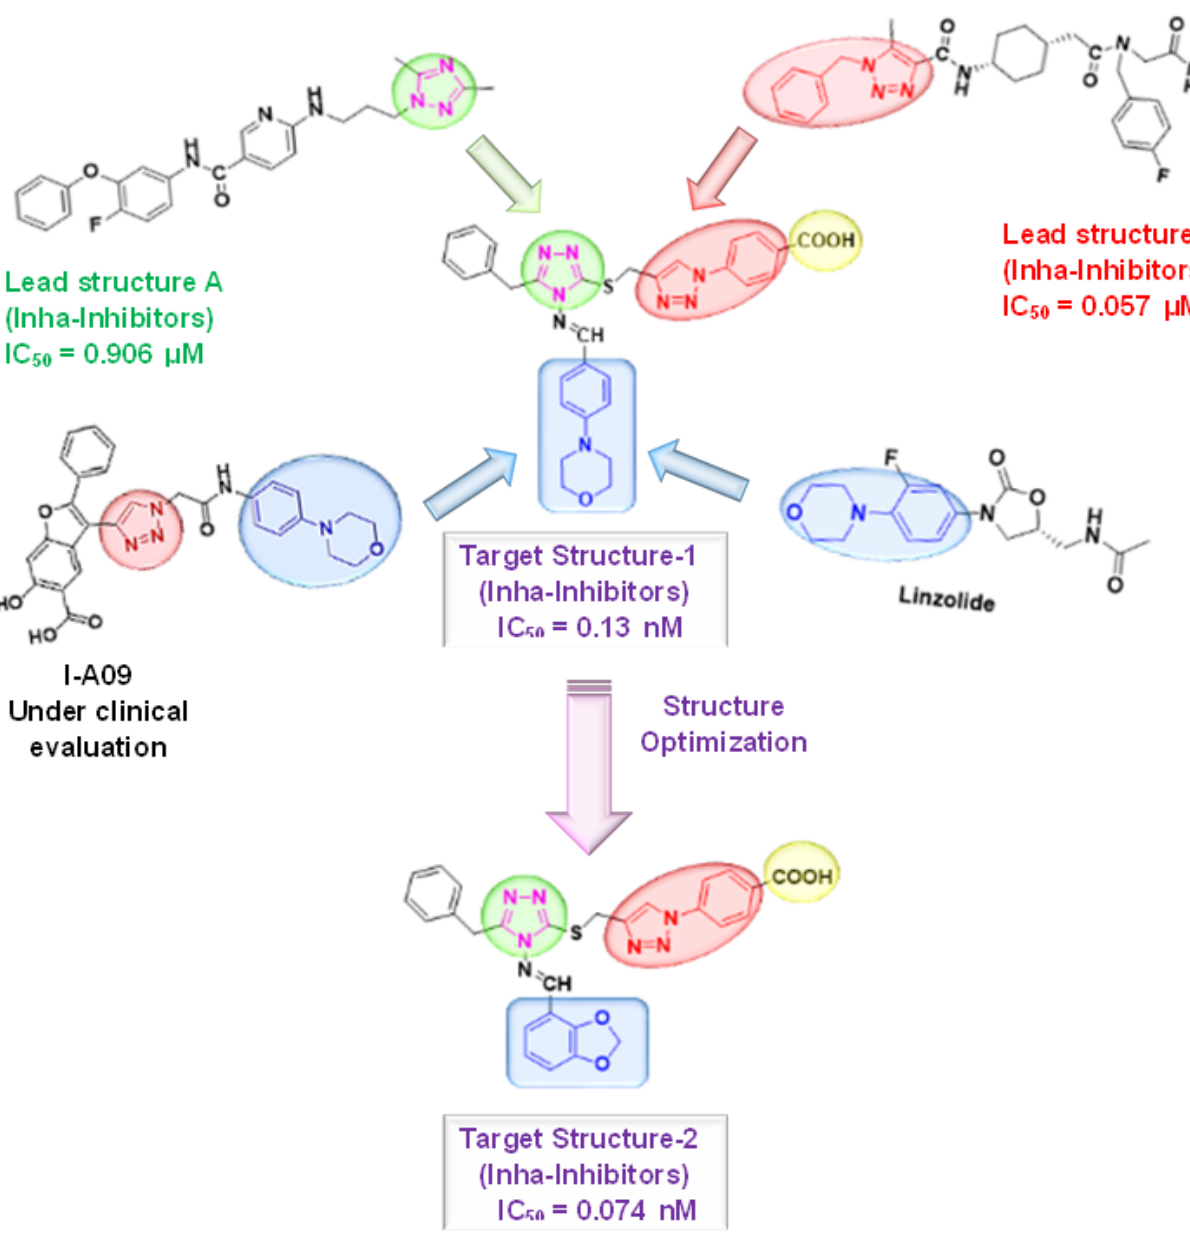
Figure 3. Structure-based rational design of target structures 1, 2 . Morpholine is a versatile moiety, a privileged pharmacophore, and an extraordinary heterocyclic motif, especially in the field of antimicrobial agents. WHO, for